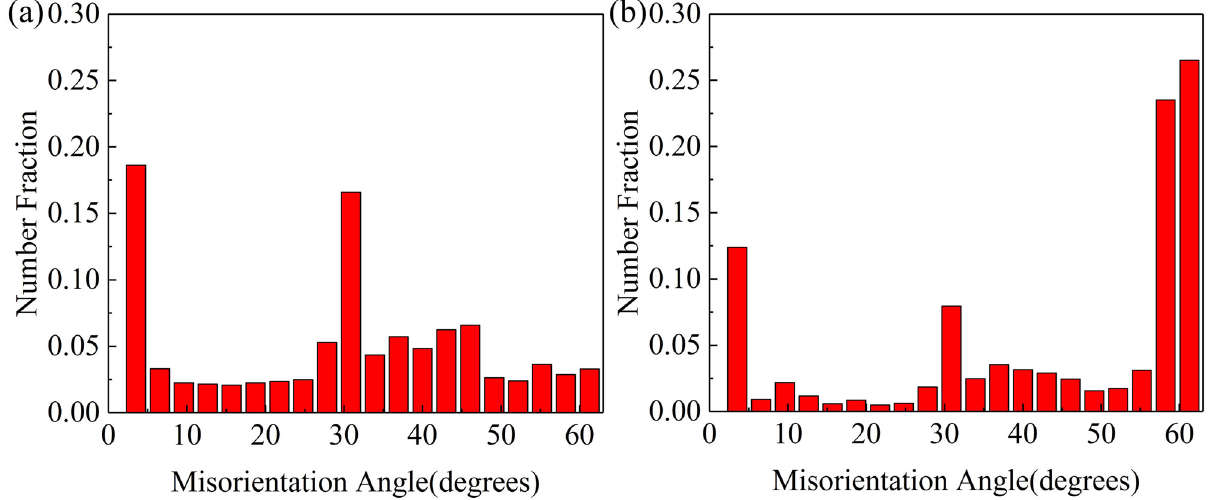
Figure 8: Misorientation angles of the samples by hot deformation at strain rate of 0.001 s − 1 : ( a ) 850°C and ( b )